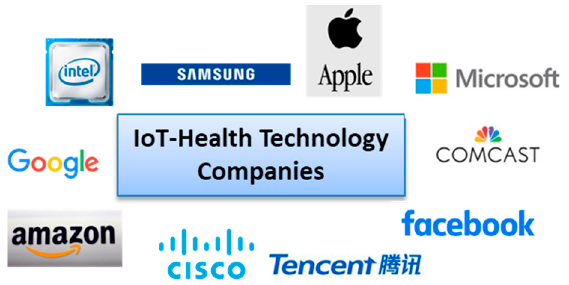
Figure 2. Technology giants in IoT and health.